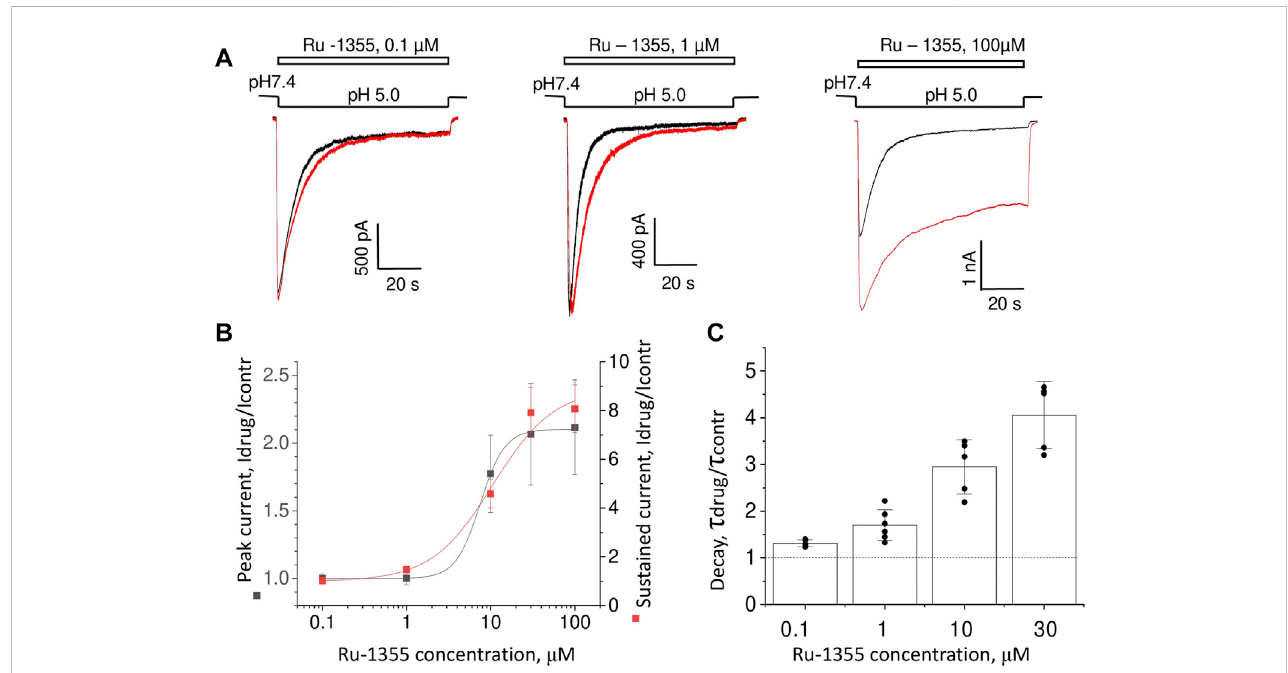
FIGURE 6 Concentration dependence of Ru-1355 action on ASIC2a. (A) , representative responses in the control condition (black) and in the presence of different concentrations of Ru-1355 (red). (B, C) , summary of the concentration dependence of the Ru-1355 effect on the peak and steady-state components (B) and on the decay time constant (C) . All three characteristics are affected with different concentration